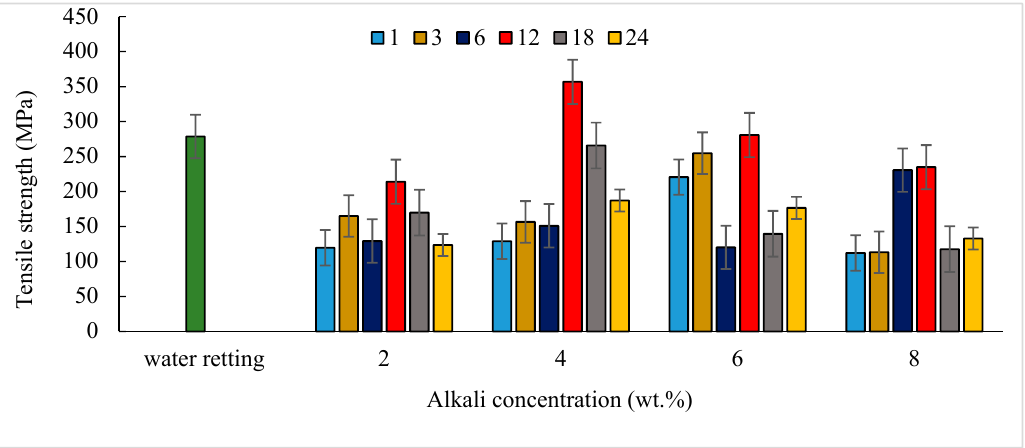
Figure 7. Tensile strength of the single-cellulosic bamboo fiber strips subjected to water retting and different alkali concentrations, for various soaking times.